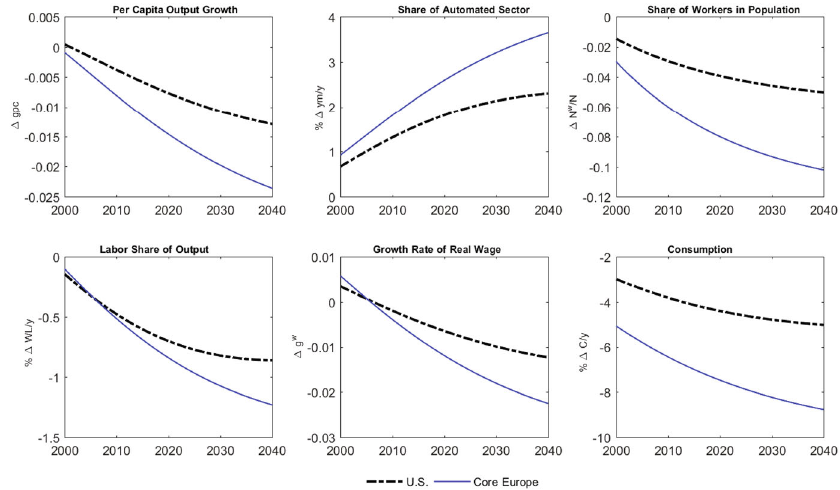
Fig. 4 Effects of demographic transition in Europe and in the USA. Note: The figure plots the effects of the projected demographic changes in each region. Unless stated, the percentage change relative to the initial balanced-growth path is reported. Per Capita Output growth = y t y balanced-growth path, Share of Automated Sector— Change relative to the initial balanced-growth path, Labour Share of Output W t L t y wage— W t W - Change relative to the initial balanced-growth path, Consumption— C t y t − 1 aggregate of Germany, France, Italy, and Spain. Source : Basso and Jimeno